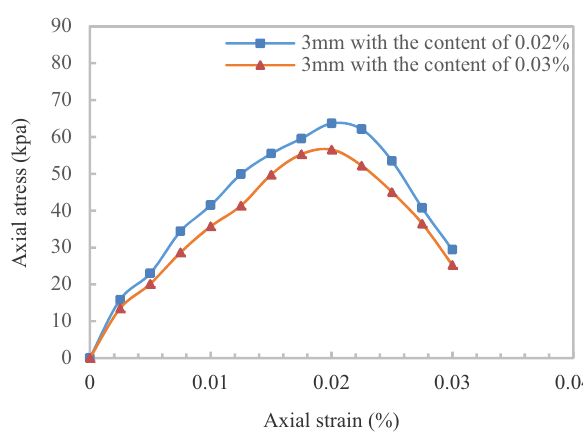
Figure 10: The stress – strain curves of di ff erent reinforcement ratios with EPS particle size of 3